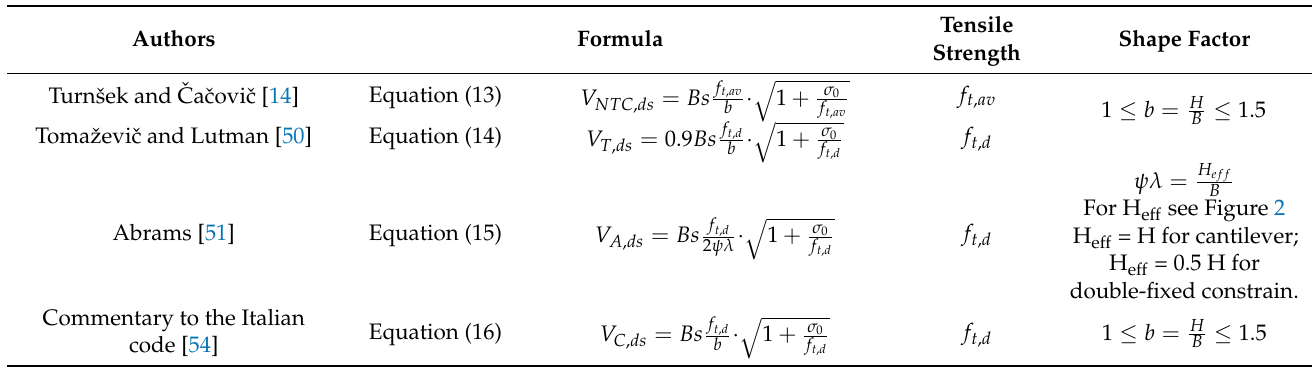
Table 3. Literature and code formulations used to predict the DS capacity of irregular/rubble masonry walls.